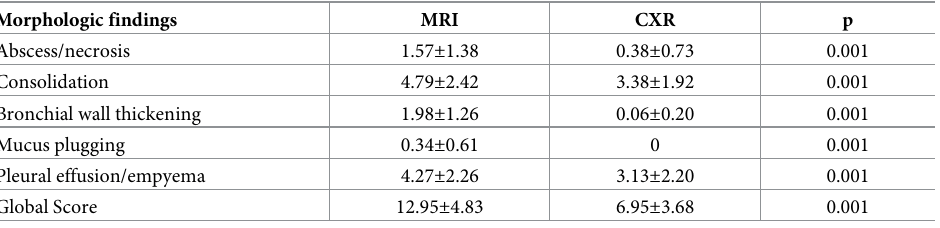
Table 5. Scores for morphologic findings in MRI and CXR at baseline.